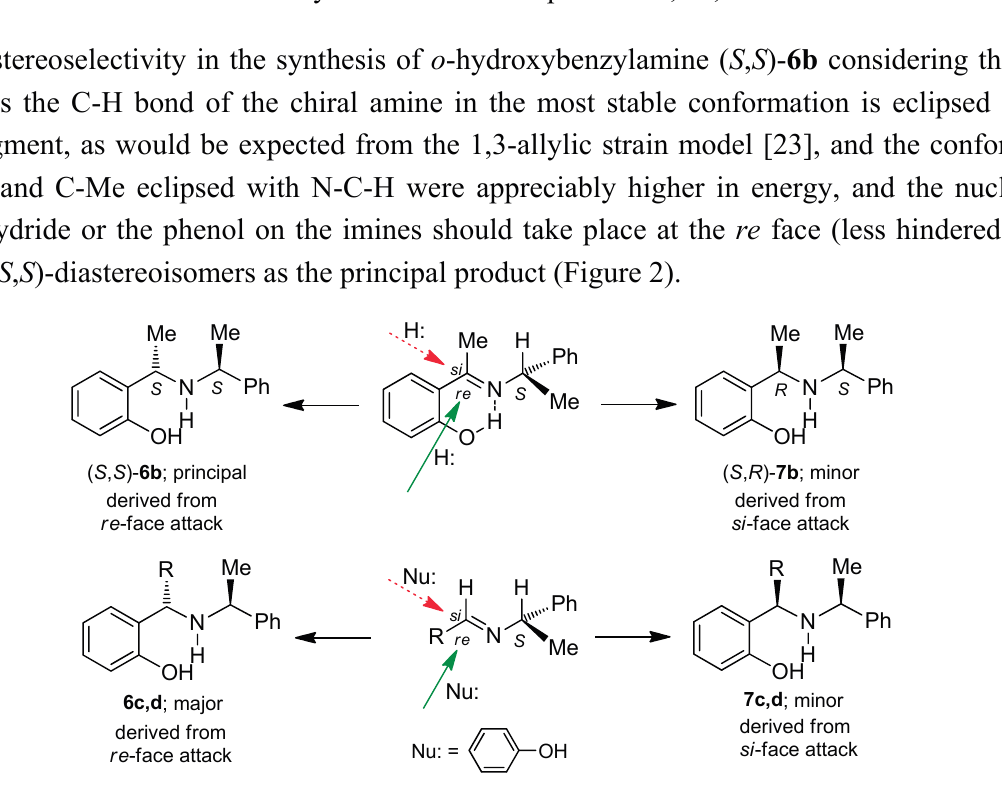
Figure 2. Proposed mechanism for nucleophilic attack of NaBH 4 and phenol onto